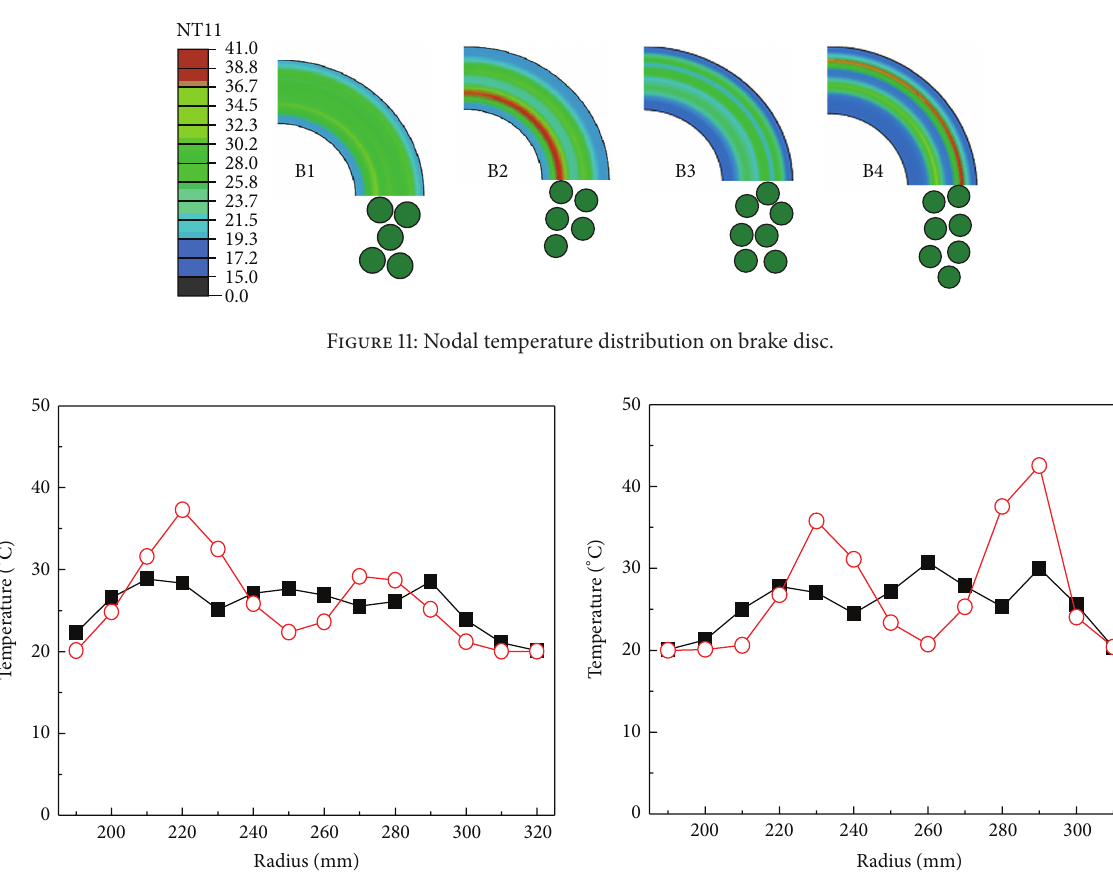
Figure 12: Relationship between nodal temperature and friction radius.